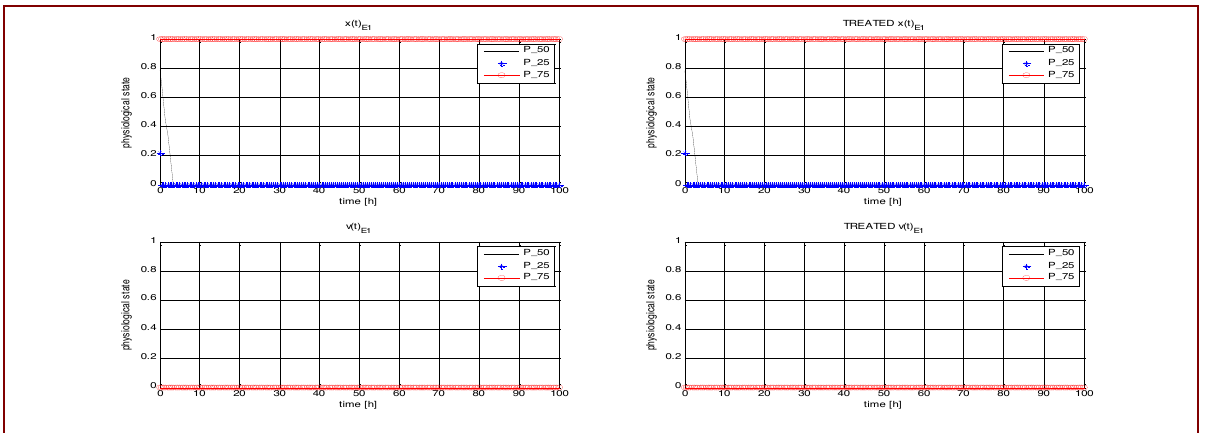
Fig. 5. On the left-hand side, it is shown the evolution of the median UNTREATED patient (x(t) and v(t)) for each variable in the set (ABCDE); on the right-hand side, it is shown the evolution of the median TREATED (0 2 ) patient (x(t) and v(t)) for each variable in the set (ABCDE). Behavior of variable E1 (Extra damage/Exposure):